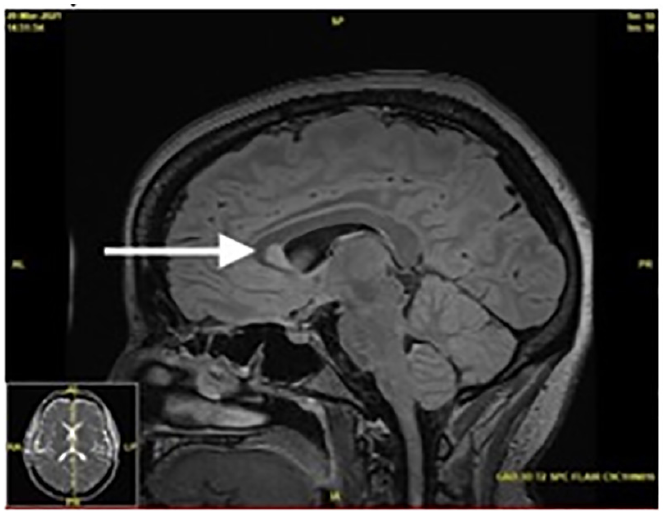
Image 3. Axial T2-weighted magnetic resonance imaging showing a high signal intensity within the left spinal cord at the level of the first lumbar vertebra